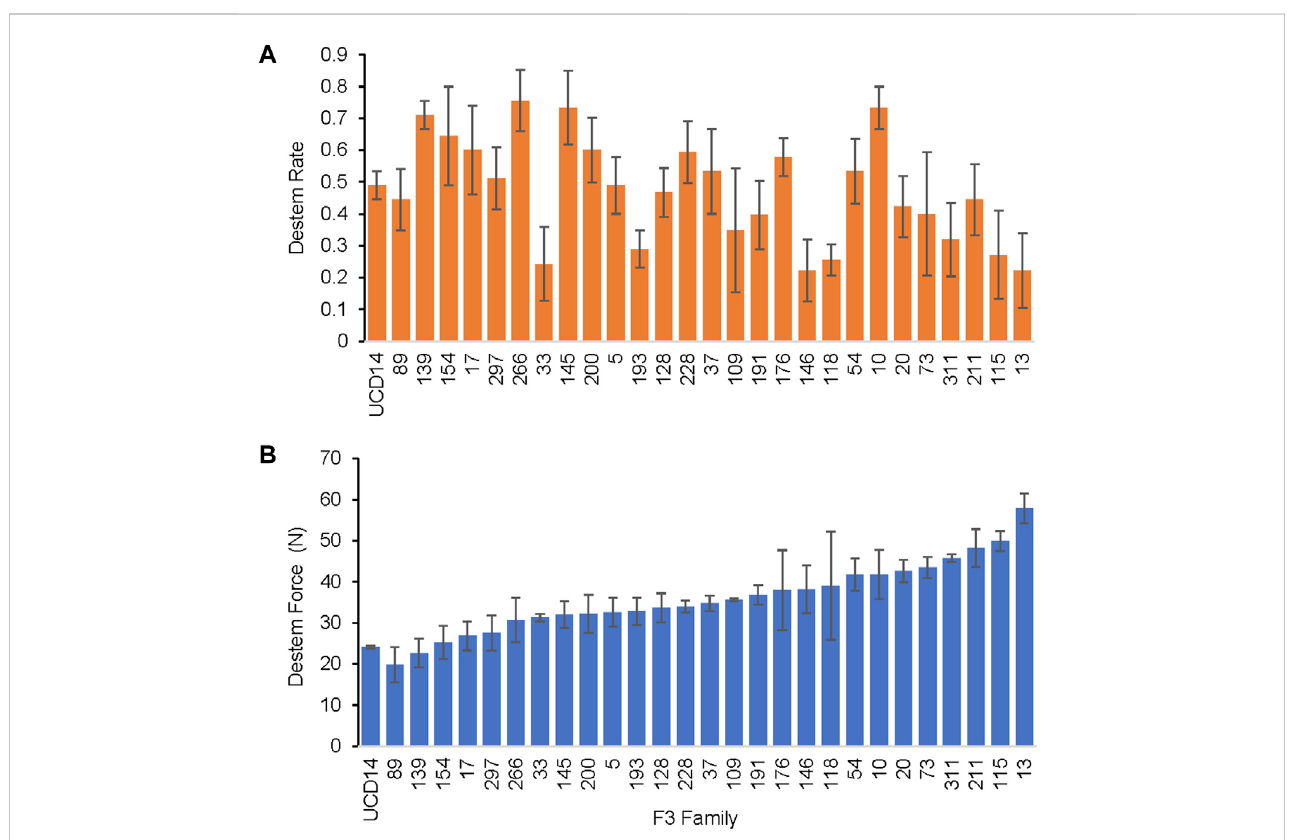
FIGURE 2 Trialin2019forQTLanalysis.RepresentativeMUC14F 3 familiesshowingarangeofdestemmingforceandfrequencywiththetorquegaugemeasuredat the mature green stage. (A) Mean fraction of fruits cleanly destemmed and (B) mean destemming force for each family. Error bars represent standard error of